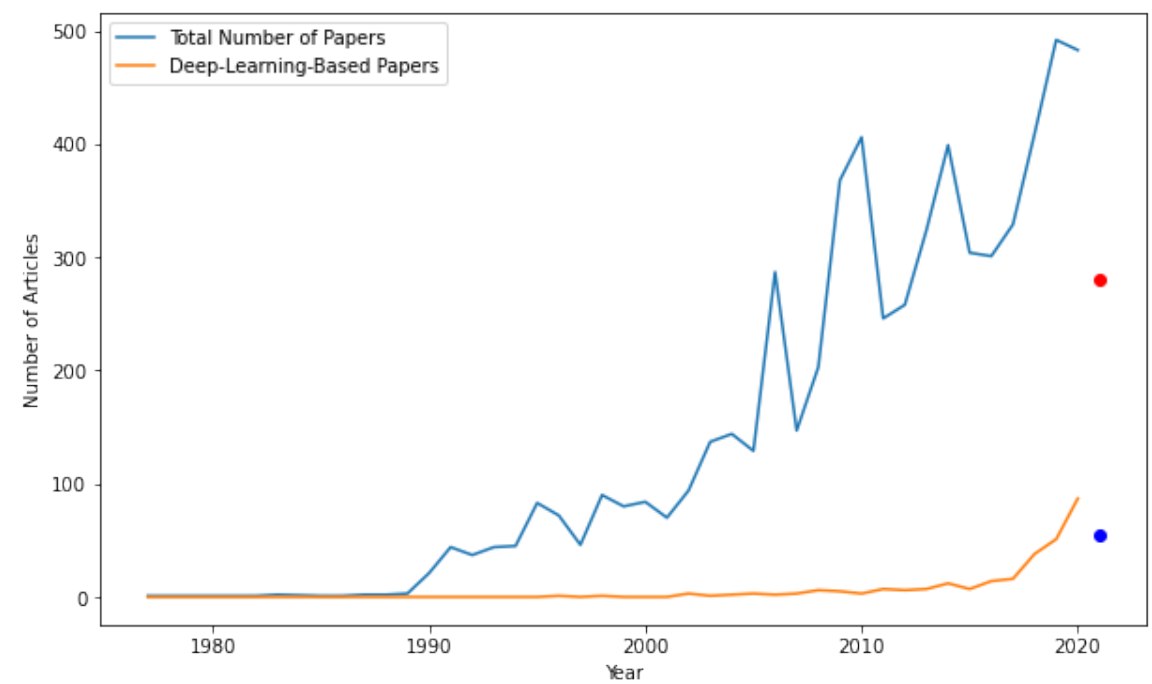
Figure 1. Number of published documents on ITMC in (1977–2021) found in the Scopus database illustrated both as a whole and as image-processing or deep-learning-based approaches (the dots represent the documents published in the year 2021 until July